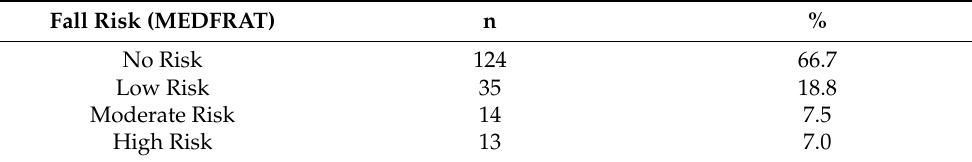
Table 5. Characterization of the sample regarding the risk of falling in the MEDFRAT.